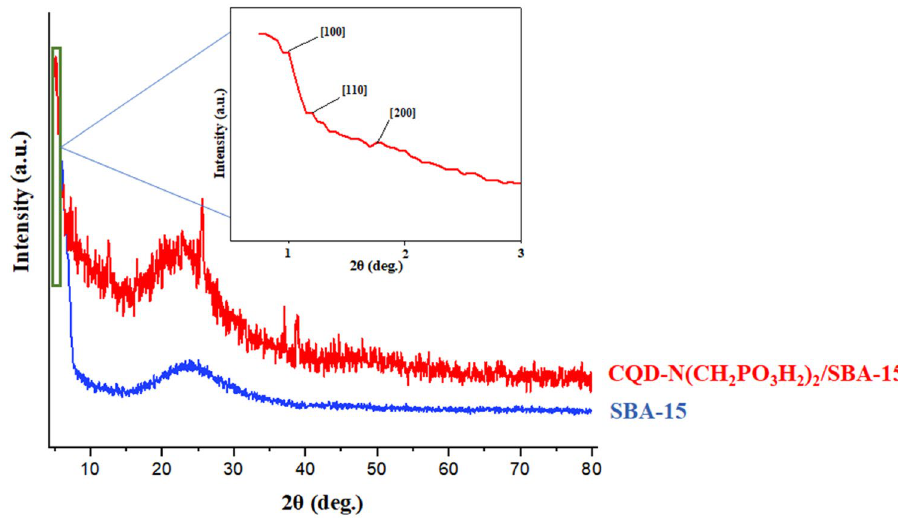
Figure 5. Comparison Low angle and PXRD of CQDs-N(CH 2 PO 3 H 2 ) 2 /SBA-15 with SBA-15.